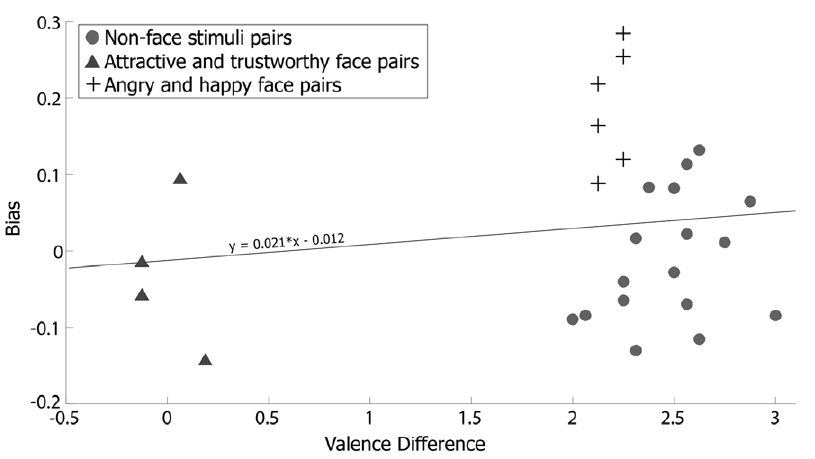
Figure 3. Results from Experiment 4. The scatter plot shows relationship between bias size and the valence difference for every image pair used in Experiments 1–3 including non-face images (grey circles), faces differing in trustworthiness or attractiveness (black triangles) and facial expressions (black crosses).